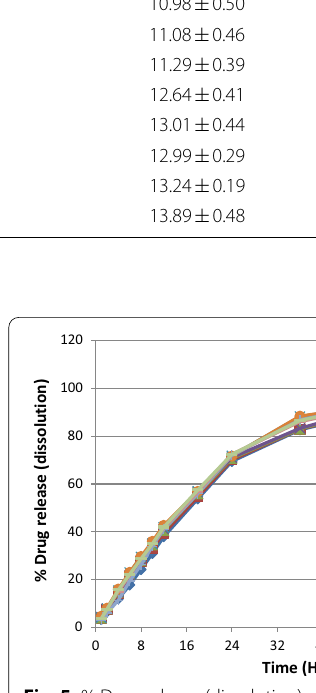
Fig. 5 % Drug release (dissolution) of formulated transdermal patch